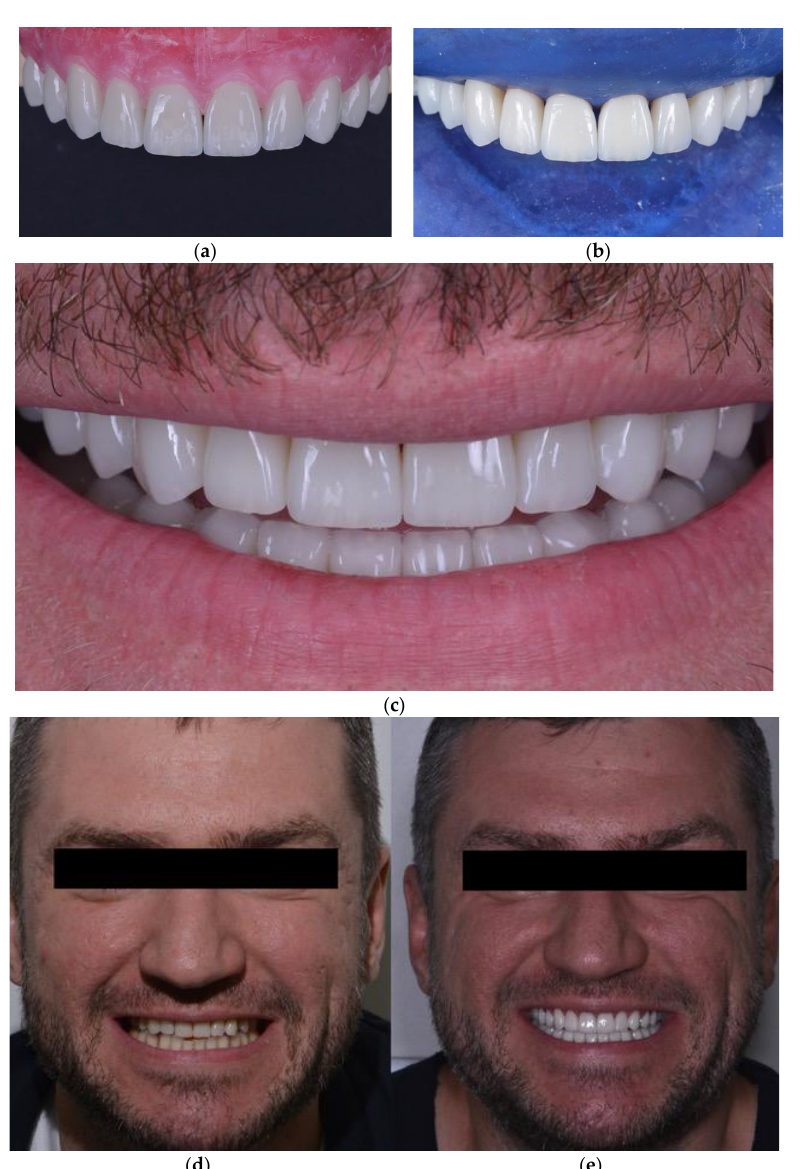
Figure 12. Ceramic restorations fixed on the teeth ( a – c ); smile view before ( d ) and after ( e ) treatment.